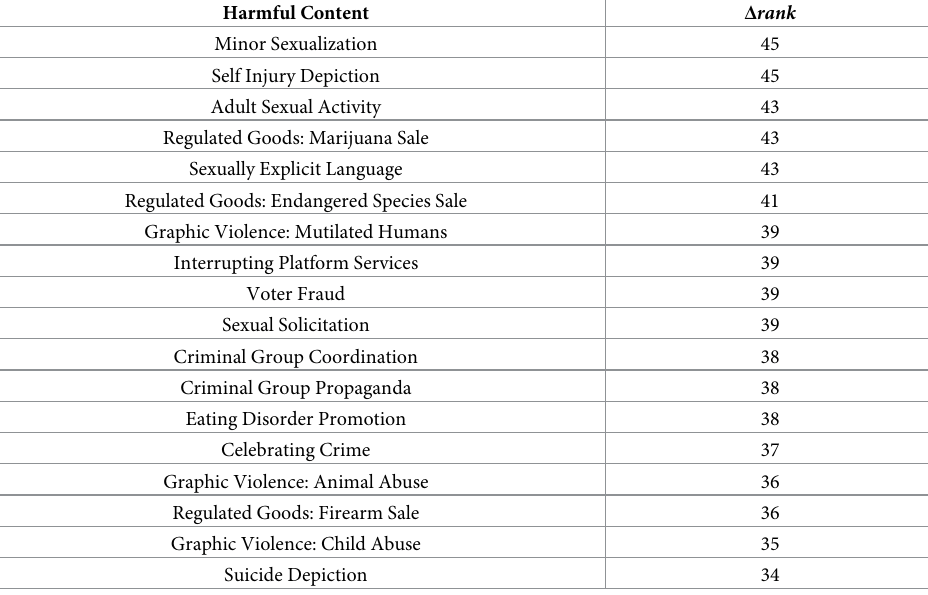
Table 5. Types of harmful content that had max ranking differences ( Δ rank )of at least 33, or half of the total num- ber of rank